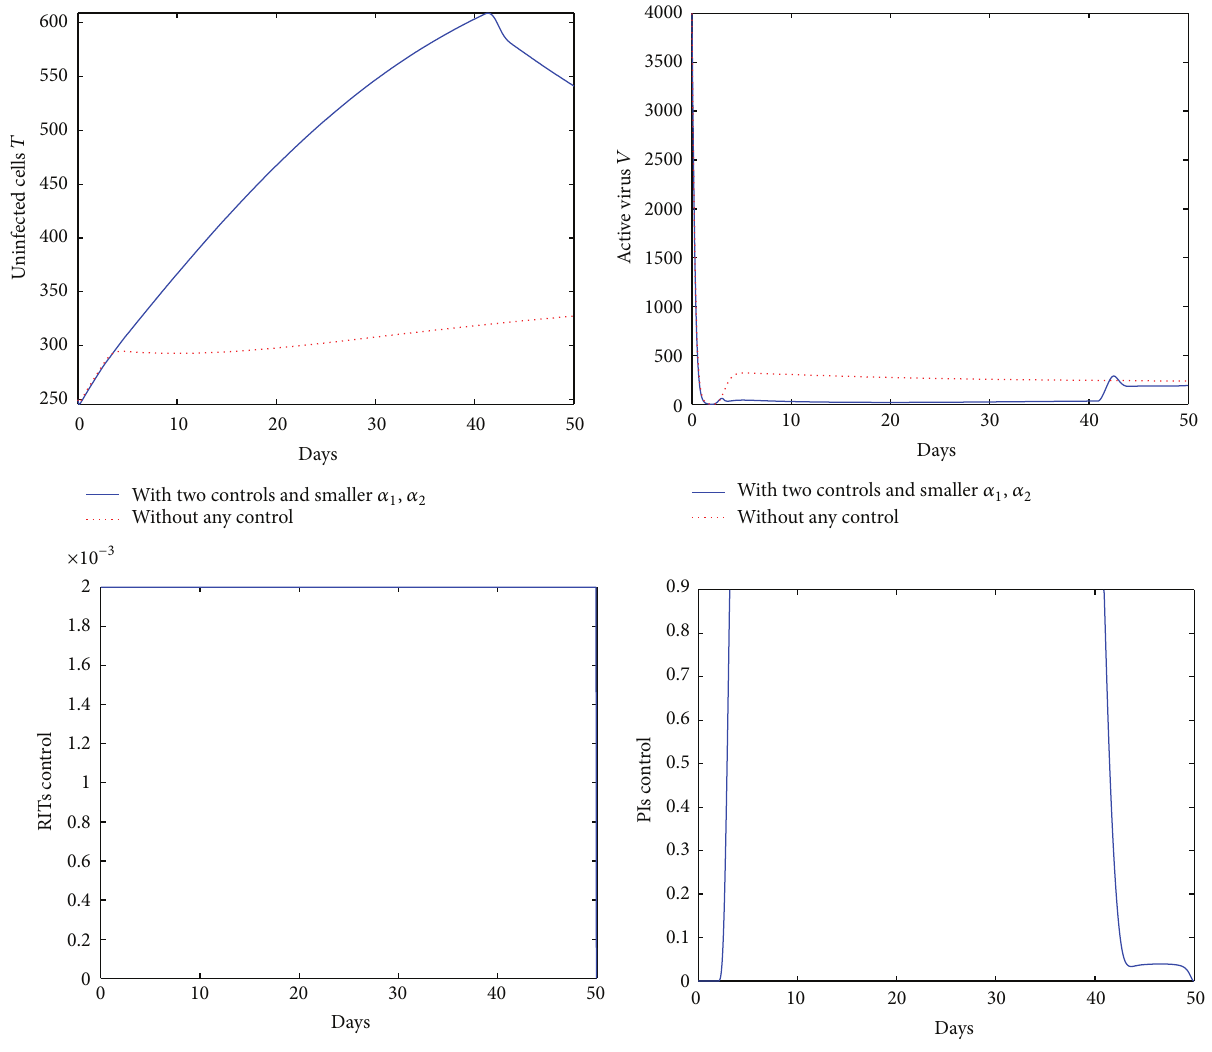
Figure 6: Optimal solutions using RTIs and PIs with sufficiently small 𝛼 1 ≈ 𝛼 2 for a 50-day